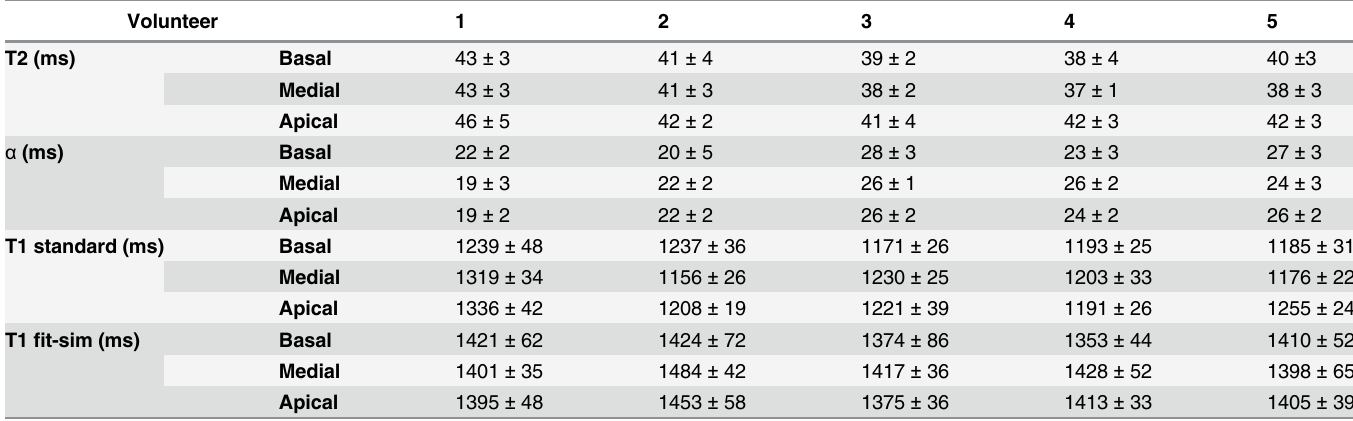
Table 3. T2, excitation flip angle and T1 values ( ± standard deviation) derived from both post-processing methods of MOLLI in the myocardium of five healthy volunteers. Volunteer